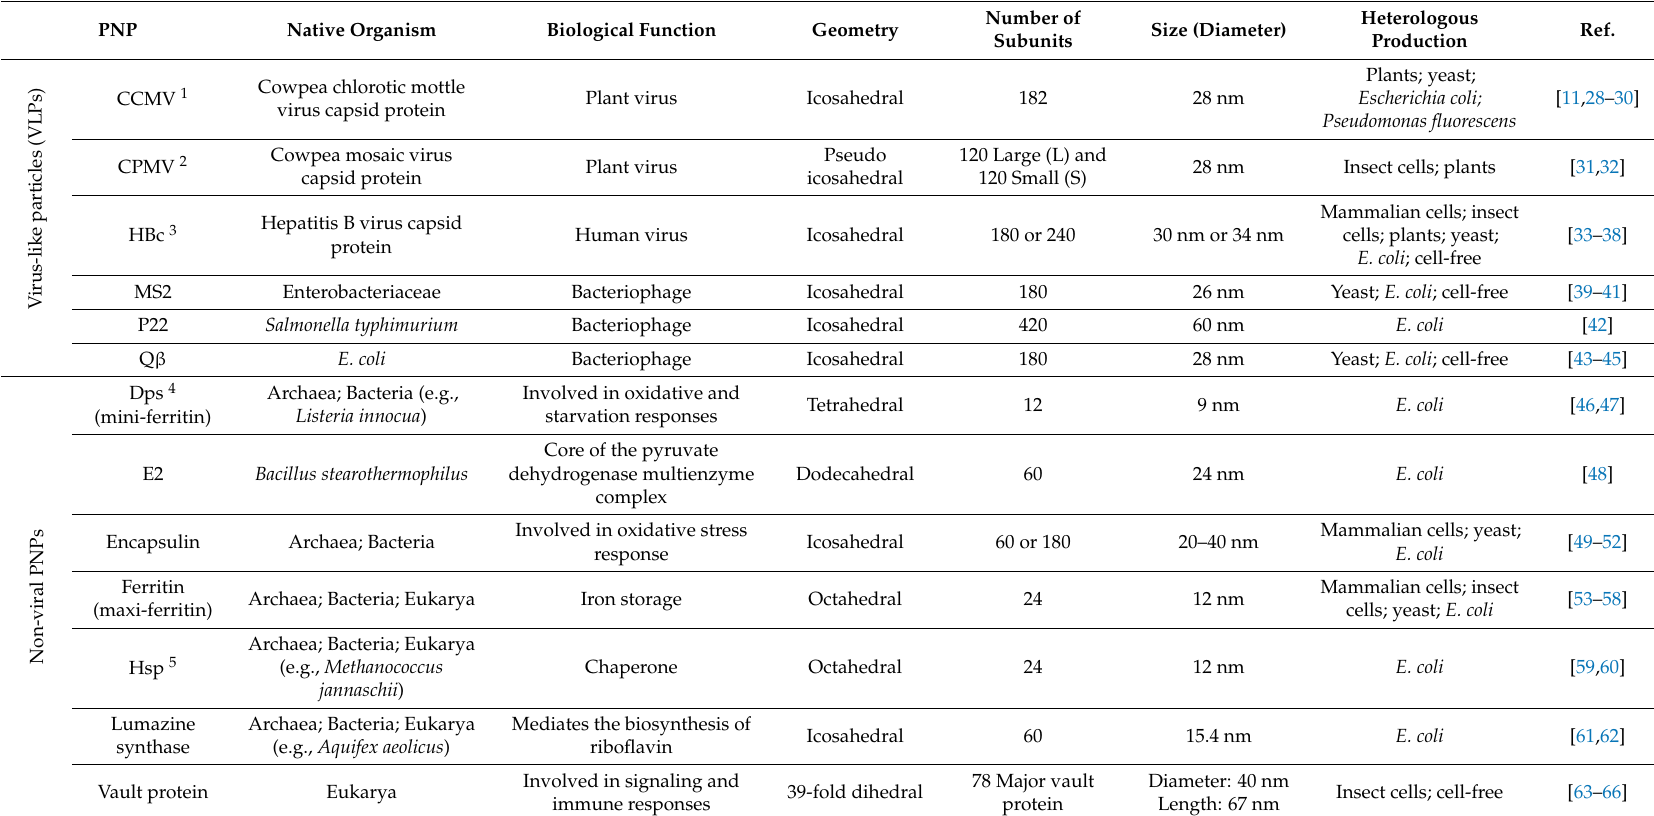
Table 1. Function, structure, and production of the most commonly used protein-based nanoparticles